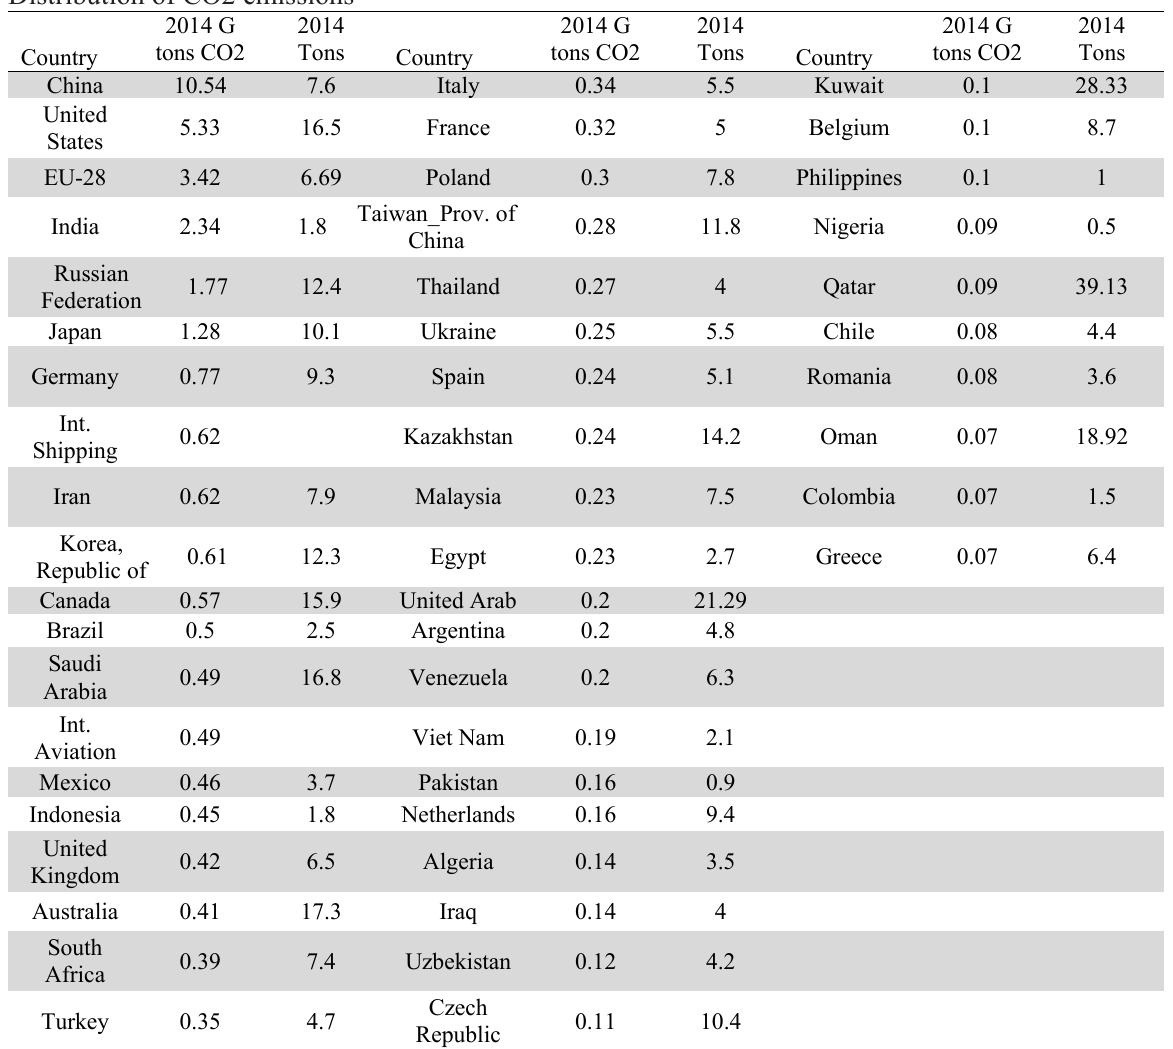
Distribution of CO2